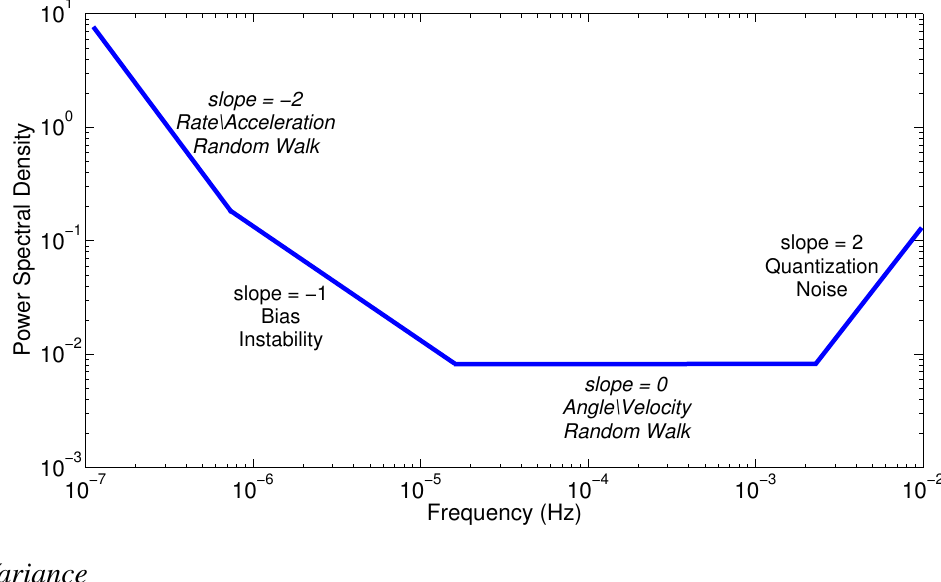
Figure 5. Hypothetical power spectral density (PSD) in single-sided form of an inertial sensor; PSD plot from the IEEE Std 1293-1998